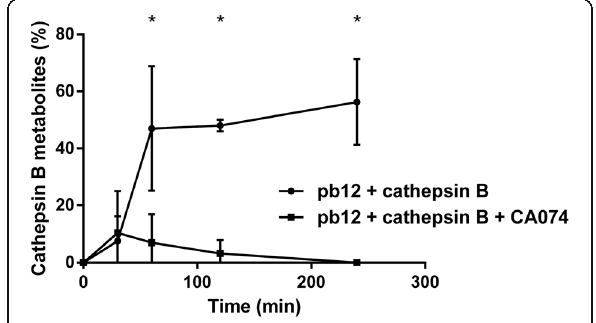
Fig. 2 Kinetics of cathepsin B metabolite formation with and without the cathepsin B inhibitor